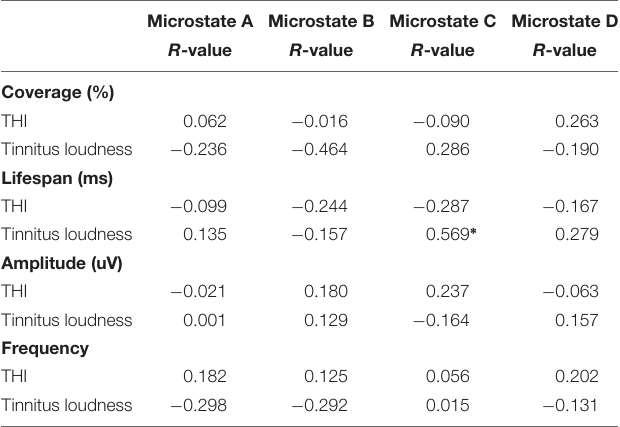
TABLE 3 | Correlations between changes of microstates and tinnitus subjective symptoms.